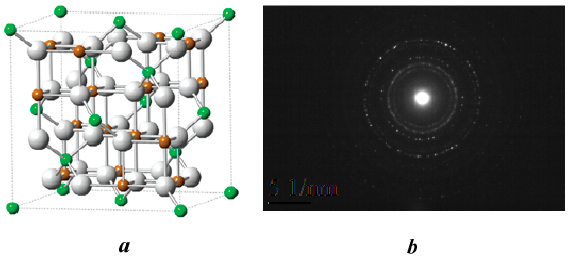
Figure 4. ( a ) Crystal structure of magnetite, Fe: green, orange; O: grey. ( b ) Diffraction pattern of the iron oxide nanoparticles (IO-NP).